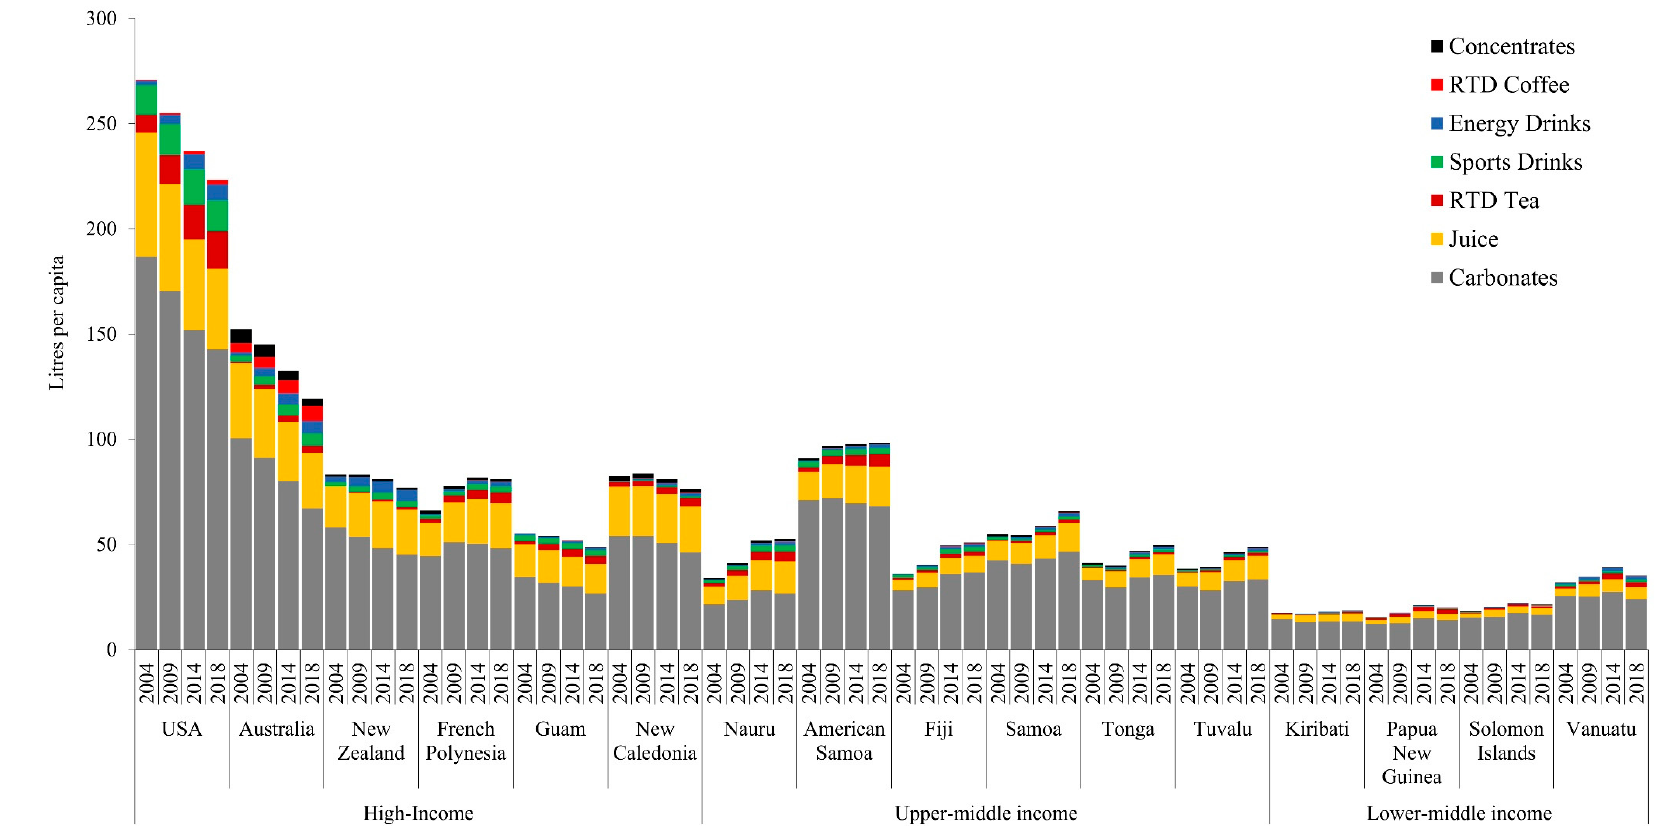
Figure 2. Per capita soft drink sales in Pacific island countries, 2004–2018, by country income level.